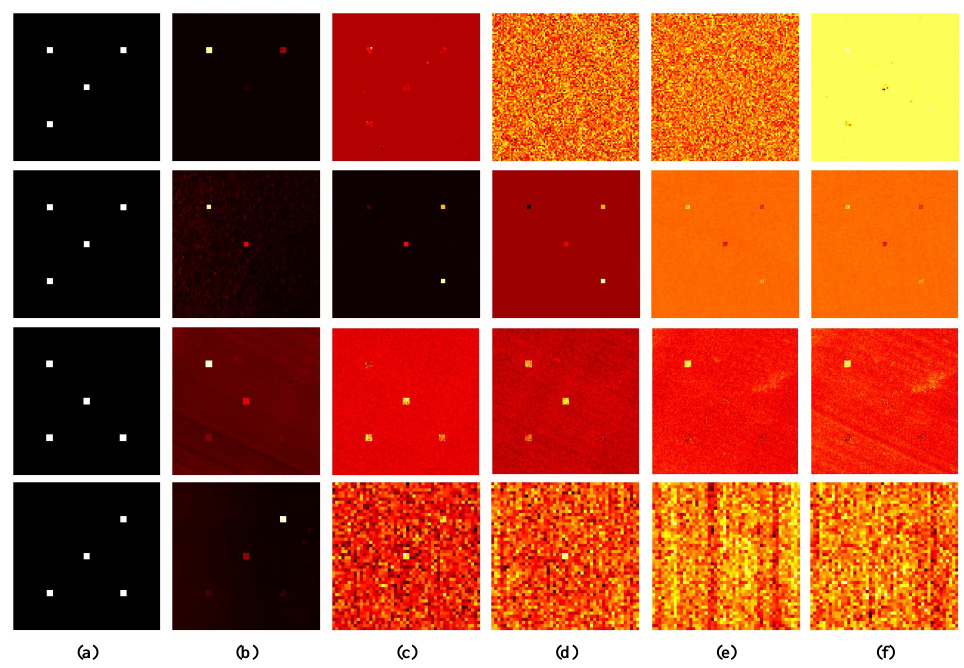
Figure 11. The underwater target detection results of compared methods for the all datasets. ( a ) Ground truth of simulated, sea, river, and lake water datasets. ( b ) SUTDF. ( c ) UTDF. ( d ) GBF. ( e ) CEM. ( f )